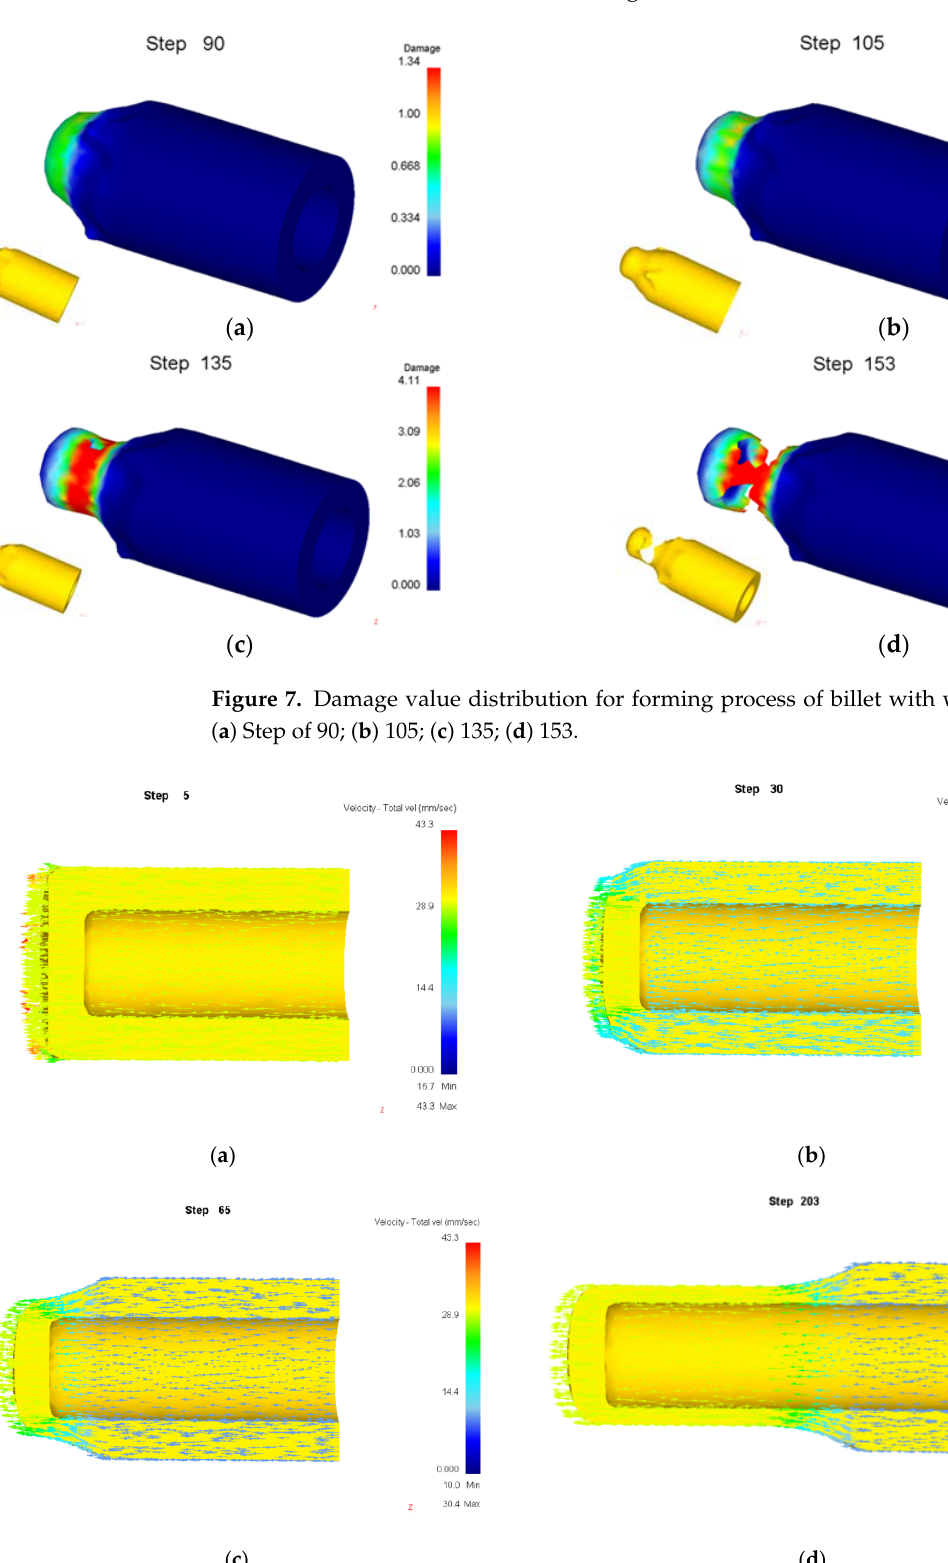
Figure 8. Velocity vector of billet with bottom thickness of 30 mm. ( a ) Step of 5; ( b ) 30; ( c ) 65; ( d ) 203. When the bottom thickness of the billet is 20 mm, the forming process is nearly same as that in Figure 7, that is, the wall is thinned and fractured. When the bottom thickness of the billet is 10 mm, the metal flow velocity vector diagram during the forming process is shown in Figure 9. It can be seen from Figure 9 that the billet wall only has a small deformation at the intersection with the bottom and the deformation of the bottom is much greater than that of the wall when the punch pushes the bottom of the billet downward. This is caused by the deformation force needed by the billet wall being much greater than that the bottom can take as the bottom of the billet is too thin. The continu- ous movement of the punch finally resulted in the penetration of the billet bottom by the punch (punching off the billet bottom). ( a )